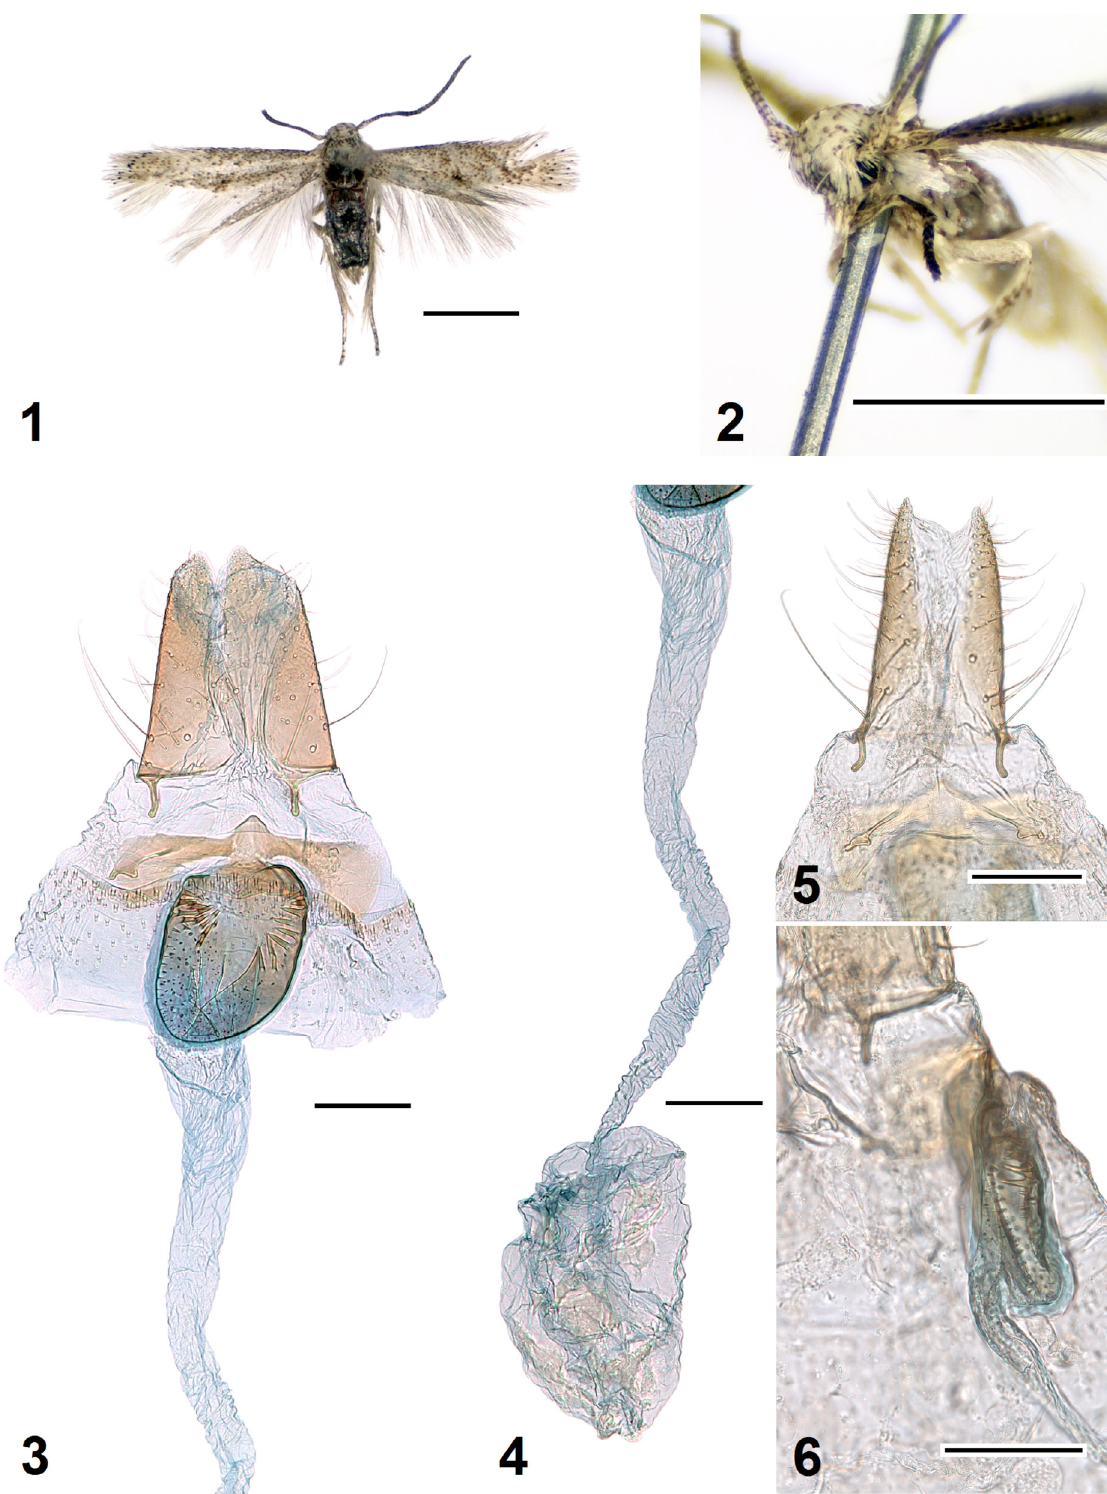
Figs 1–6. Urodeta longa Sruoga & Kaila sp. nov., holotype, ♀ (MZH VS1/29.03.19, in glycerol before permanent mounting in Euparal). 1 . Adult. 2 . Head, latero-frontal view. 3 . Caudal part of female genitalia. 4 . Ductus and corpus bursae. 5 . Papillae anales and apophyses, dorsal view. 6 . Antrum, lateral view. Scale bars: 1–2 = 1 mm; 3–6 = 0.1